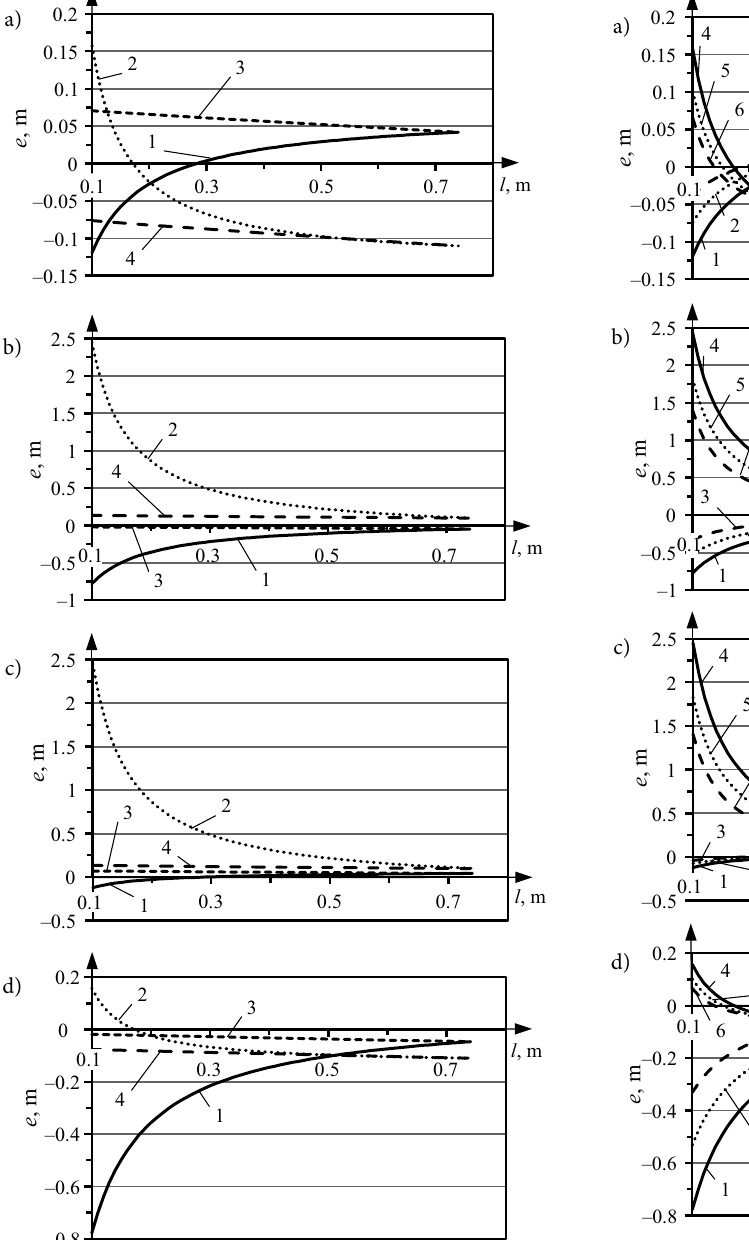
Fig. 7. Permissible limits of pretensioned strand position when hight of prestressed concerete member is variable: a) when cracks aren’t allowed at transfer and at service; b) when cracks are allowed at transfer and service; c) when cracks aren’t allowed at transfer, but are allowed at service; d) when cracks are allowed at transfer, but aren’t allowed at service: 1, 2 – respectively eccentricity at transfer and at service by estimating linear variation of strand stresses; 3, 4 – respectively eccentricity at transfer and at service by estimating constant strand prestress, rational postition of reinforcment at transfer and at service stages are out of the range of member cross-section. In this case pretensioning force or cross- section dimensions should be reduced or concrete cracking should be limited.